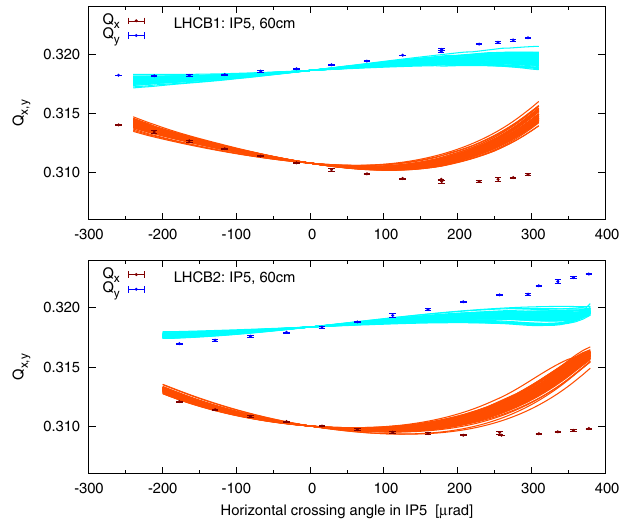
FIG. 11. Measured and modeled variation of tune in beam 1 (top) and beam 2 (bottom) with the horizontal crossing angle in ¼ 0 . 6 m. Adjustments were applied to the measured IP5, at β (cid:1) IP 5 tune data to reflect the crossing angle determined from measured orbit data, rather than the applied crossing angle trim. The simulation was matched to initial conditions using the measured crossing